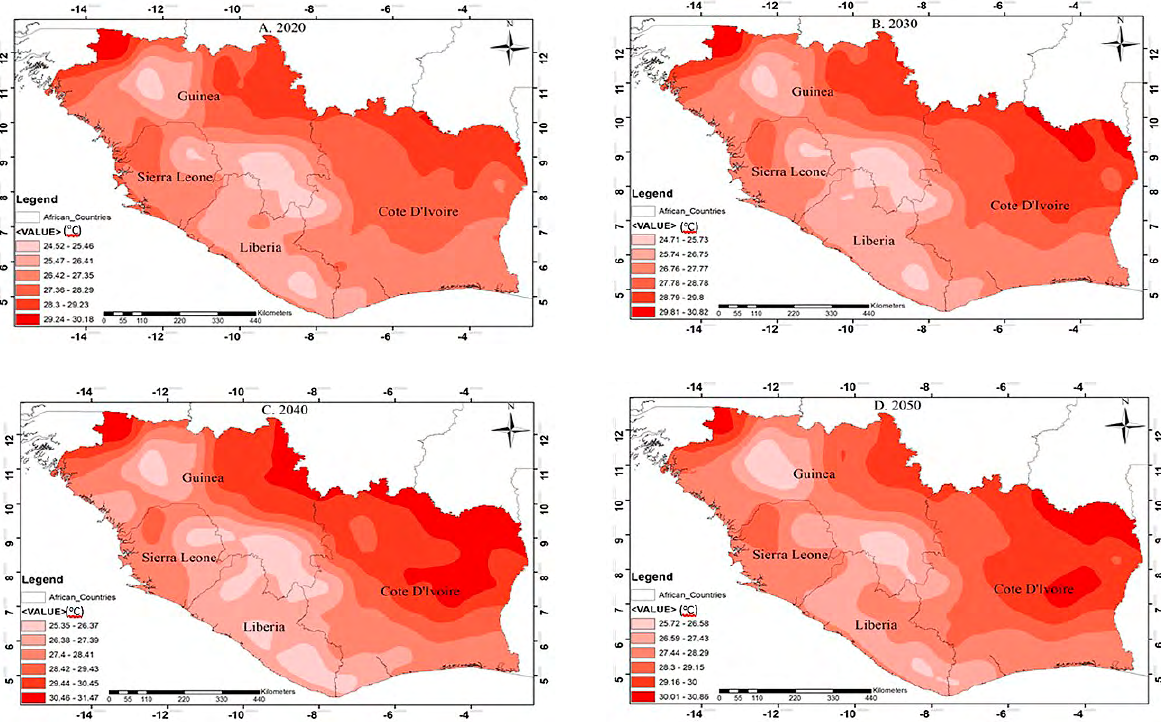
Figure 3. Decadal Spatial Distribution of Average Temperature ( o C) in the MRU region for the period